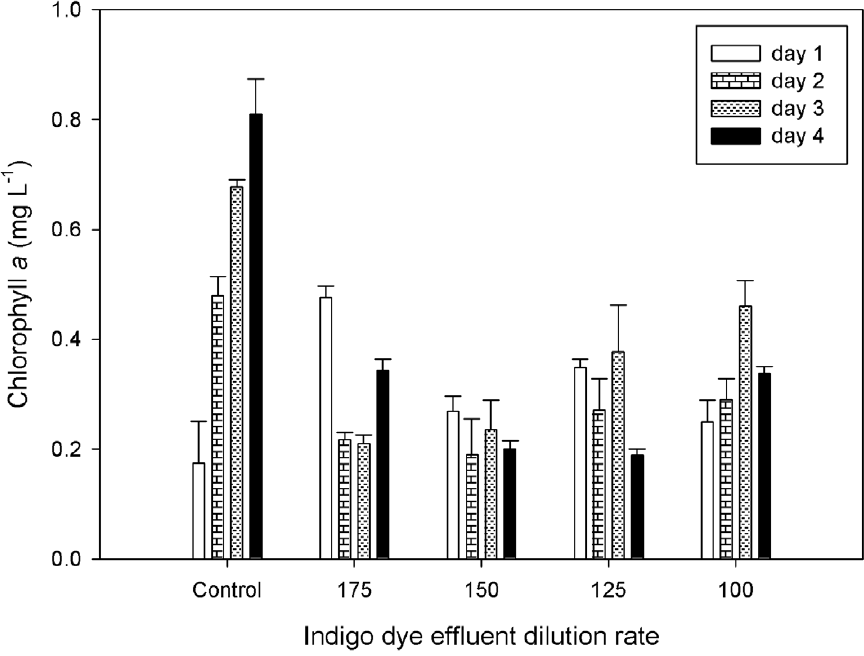
Fig. 1 - Chlorophyll a concentration (mg L -1 ) of Scenedesmus quadricauda exposed to different indigo dye effluent concentrations.